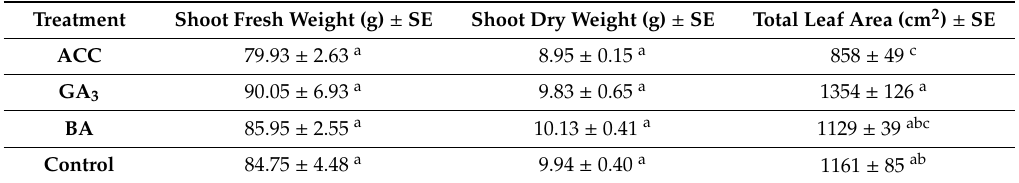
Table 2. Shoot fresh weight, shoot dry weight and total leaf area of pepper plants sprayed with 100 µ M of ACC, GA 3 and BA. Values are the mean ± S.E. of four replicates, with di ff erent letters denoting significant di ff erences between means (post-hoc LSD p <